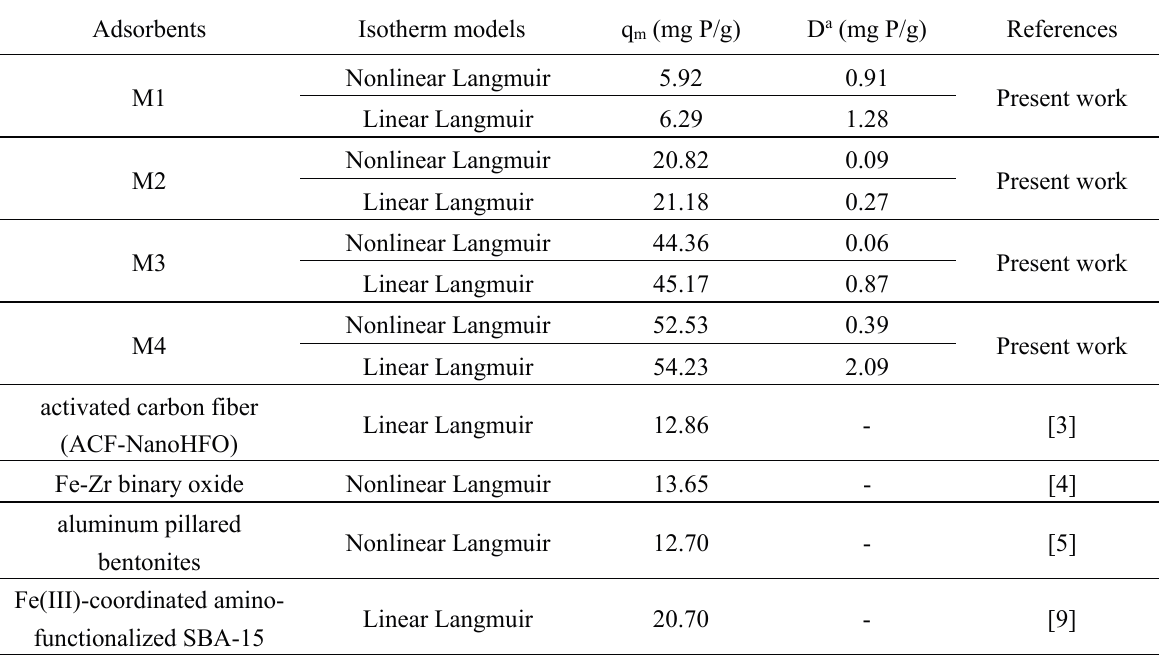
Table 5. Comparison of maximum adsorption capacities by linear and nonlinear isotherm studies.